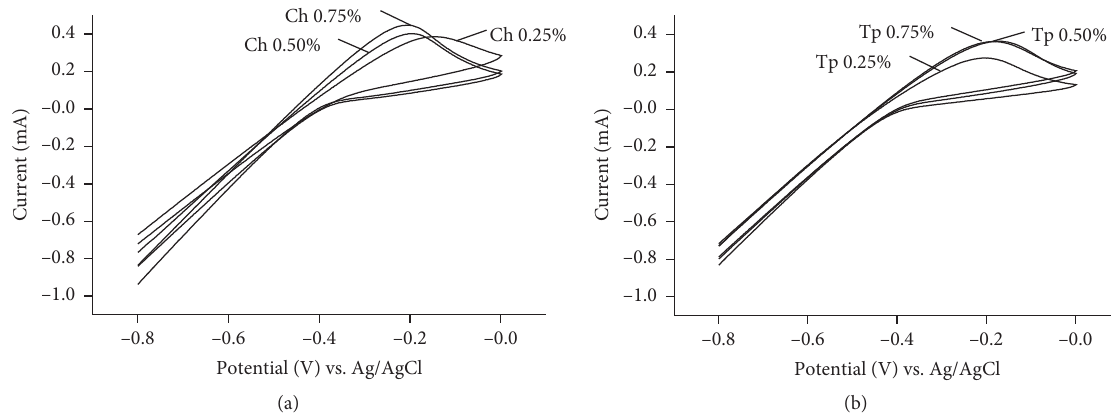
Figure 4: Cyclic voltammograms of solution containing (a) FeG 10 mM-Ac 2.5% at varying Ch concentrations and (b) FeG 10mM-Ac 2.5%-Ch0.50% at various Tp concentrations, v � 0.20V/s. Table 1: Density and viscosity of FeG-Ac solution and FeG-Ac-Ch solution. Density at 25 ° C (g/ml) Viscosity at 25 ° C (Cst) FeG-Ac-Ch solution at various Ch FeG-Ac-Ch solution at various Ch FeG-Ac solution FeG-Ac solution